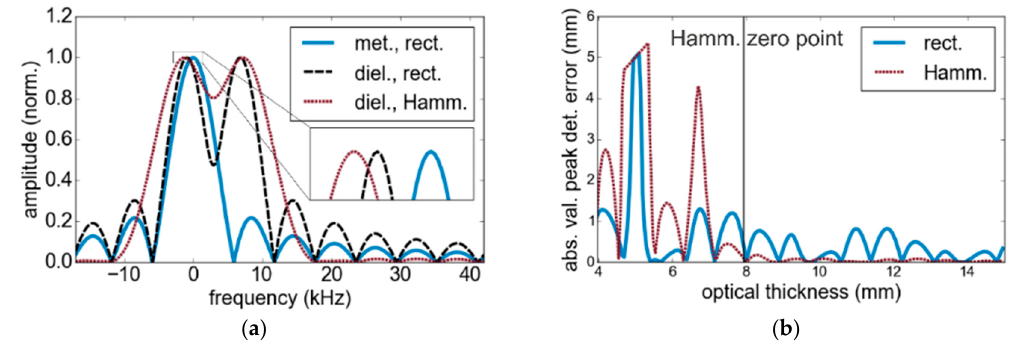
Figure 2. (a) Fourier amplitude spectrum of a single metal reflector (met.) in the calibration plane and a combination of two dielectric reflectors (diel.) with (Hamm.) and without (rect.) the application of a Hamming window function. ( b ) Peak detection error using a rectangular (blue) and a Hamming (red) window function.